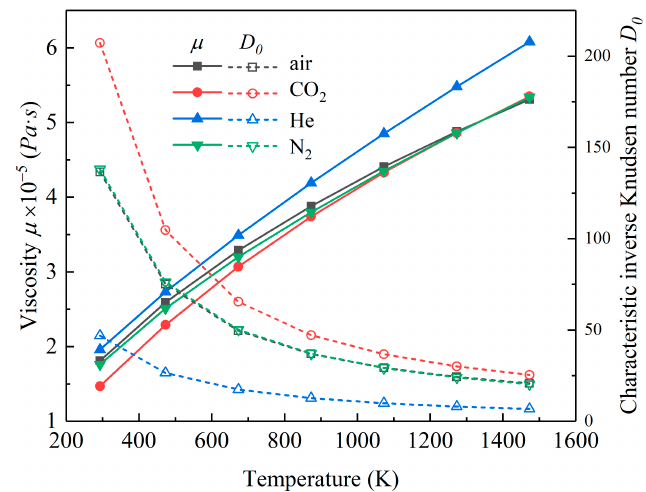
Figure 5. Variation of μ and D 0 at different temperatures.